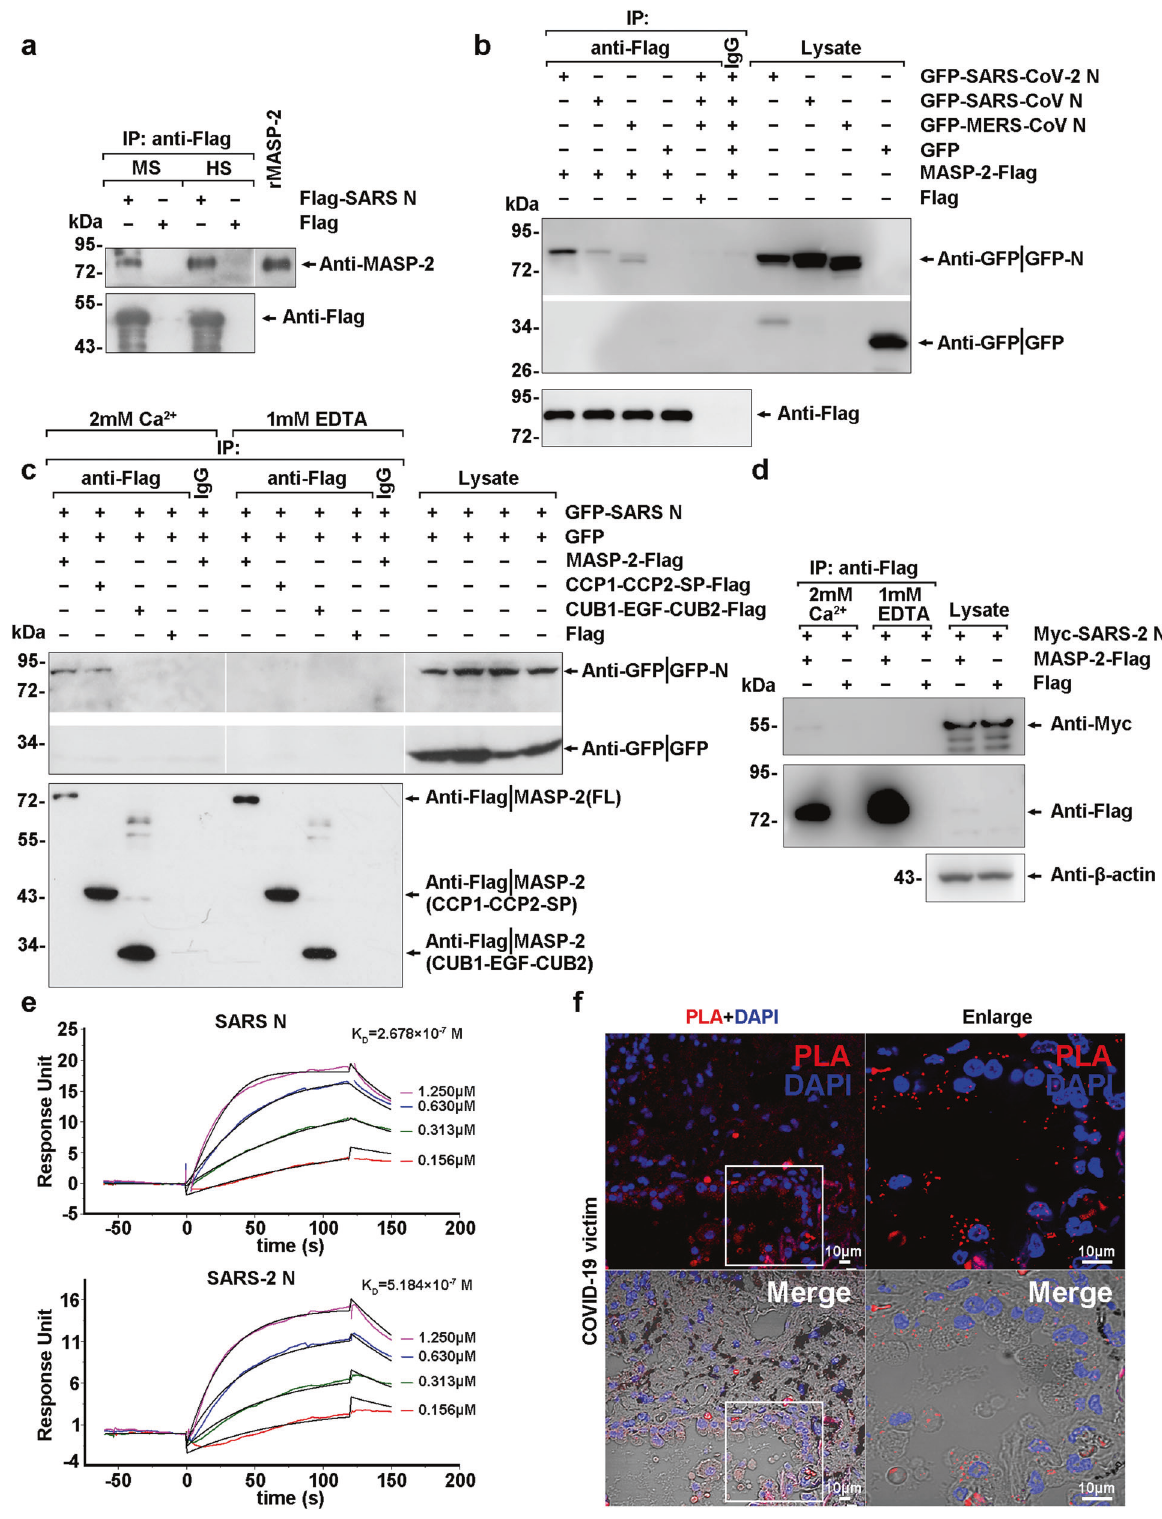
COVID-19 patients in a phase II clinical trial. 22 These reports indicate that the complement pathways are activated in highly pathogenic human coronavirus infection, but the detailed mechanism underlying these excessive complement activations is not